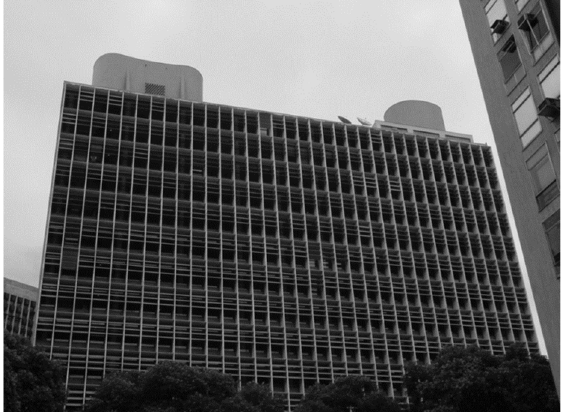
Figure 11. Brise-soleil of the Office of Education Authority in Rio de Janeiro.